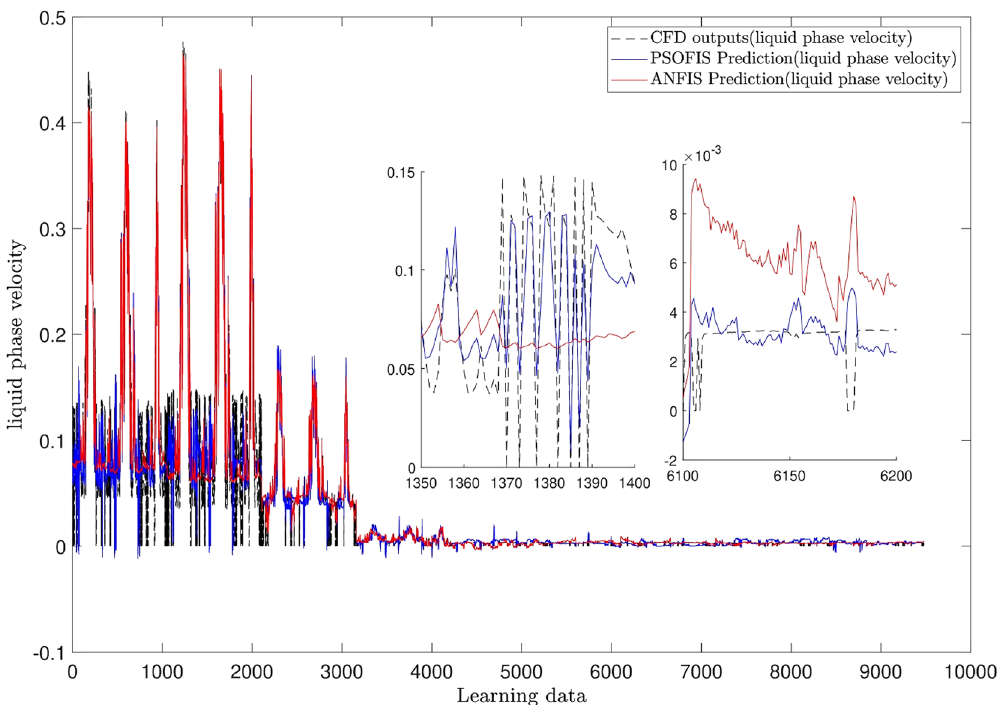
Figure 8. Pattern of liquid phase velocity in different